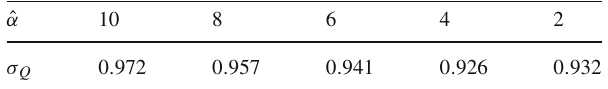
Table 2 The characteristic quantity of incoherence σ Q for γ = − 1 / 12 and different ˆ